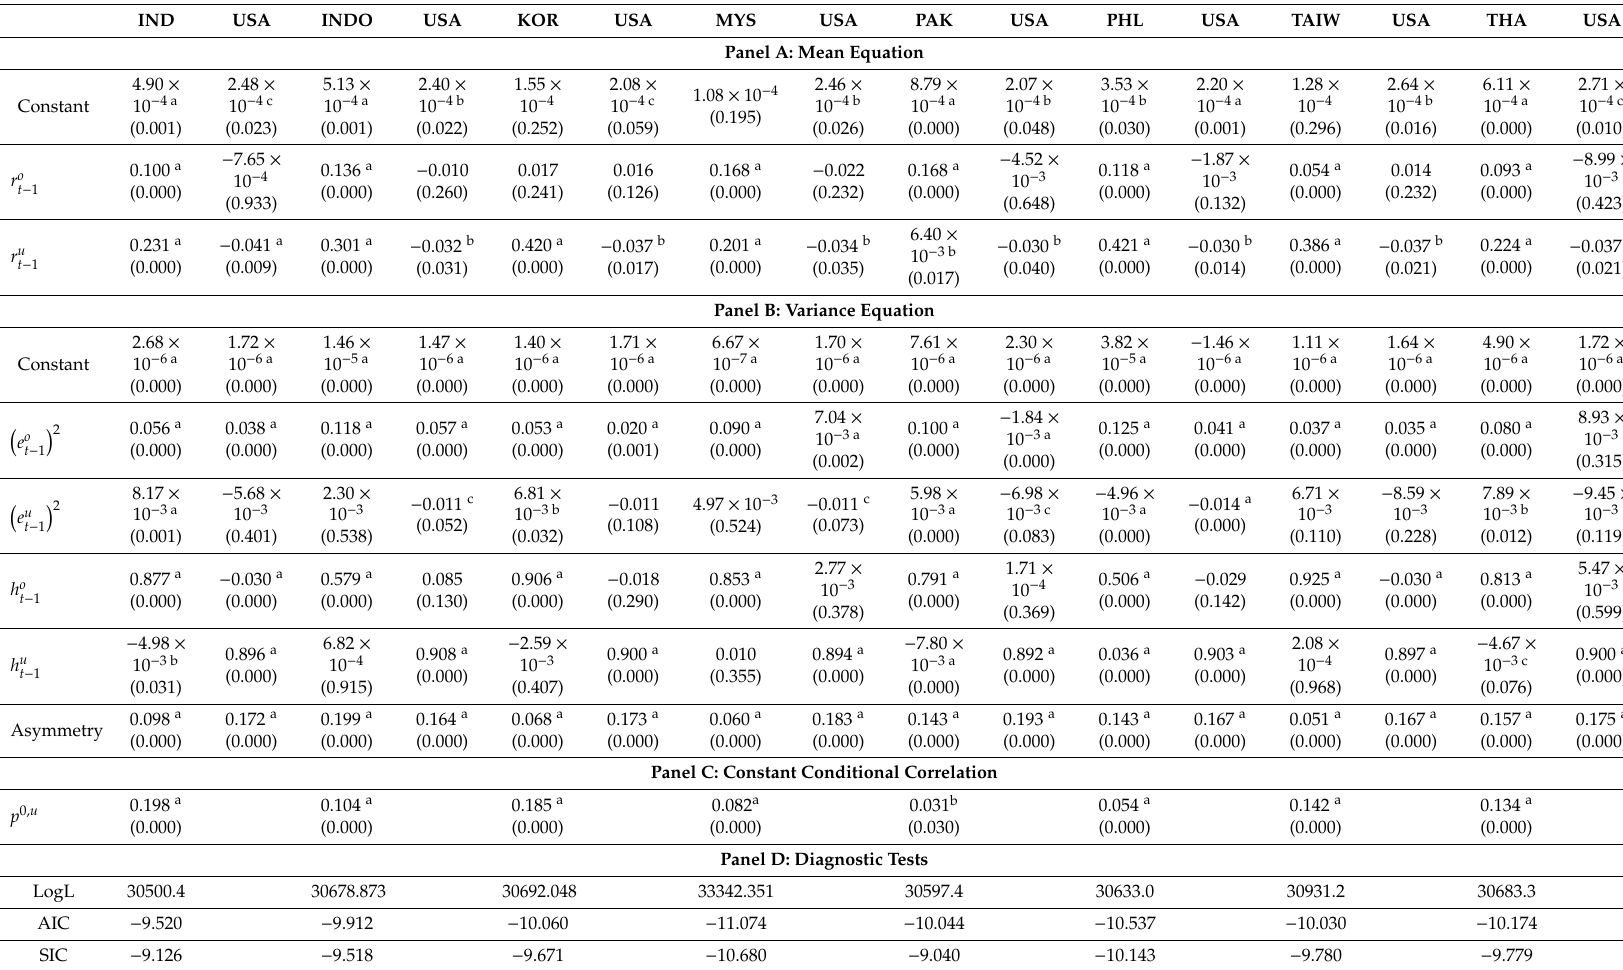
Table 2. Estimates of bivariate Vector Autoregressive-Generalized Autoregressive Conditional Heteroskedasticity (VAR-AGARCH) for the USA and Asian stock markets during a full sample